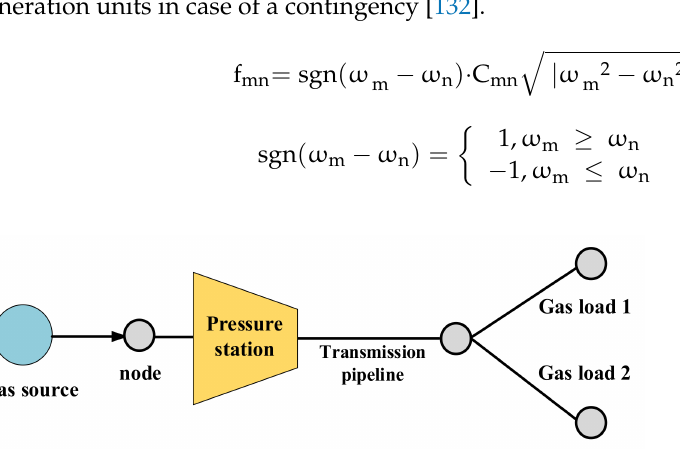
Figure 9. Framework of a typical natural gas transmission